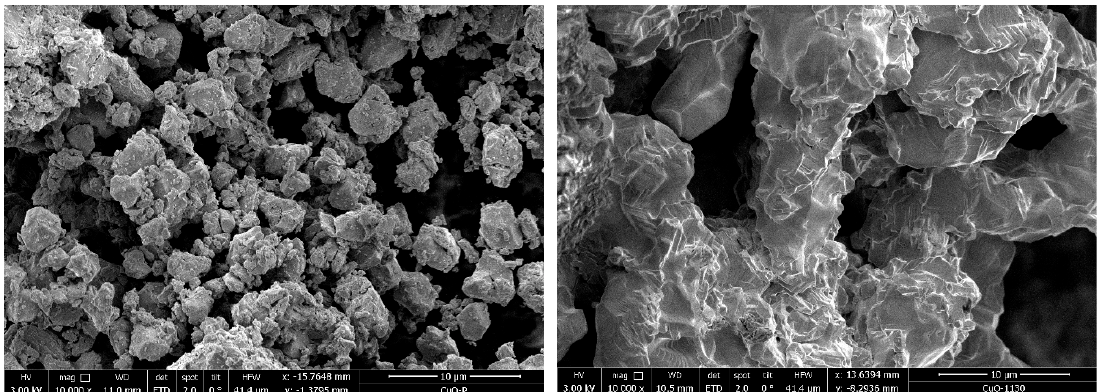
Figure 13. Comparison of the particle change of CuO before ( left ) and after ( right ) the simultaneous thermal analysis (STA) experiment.